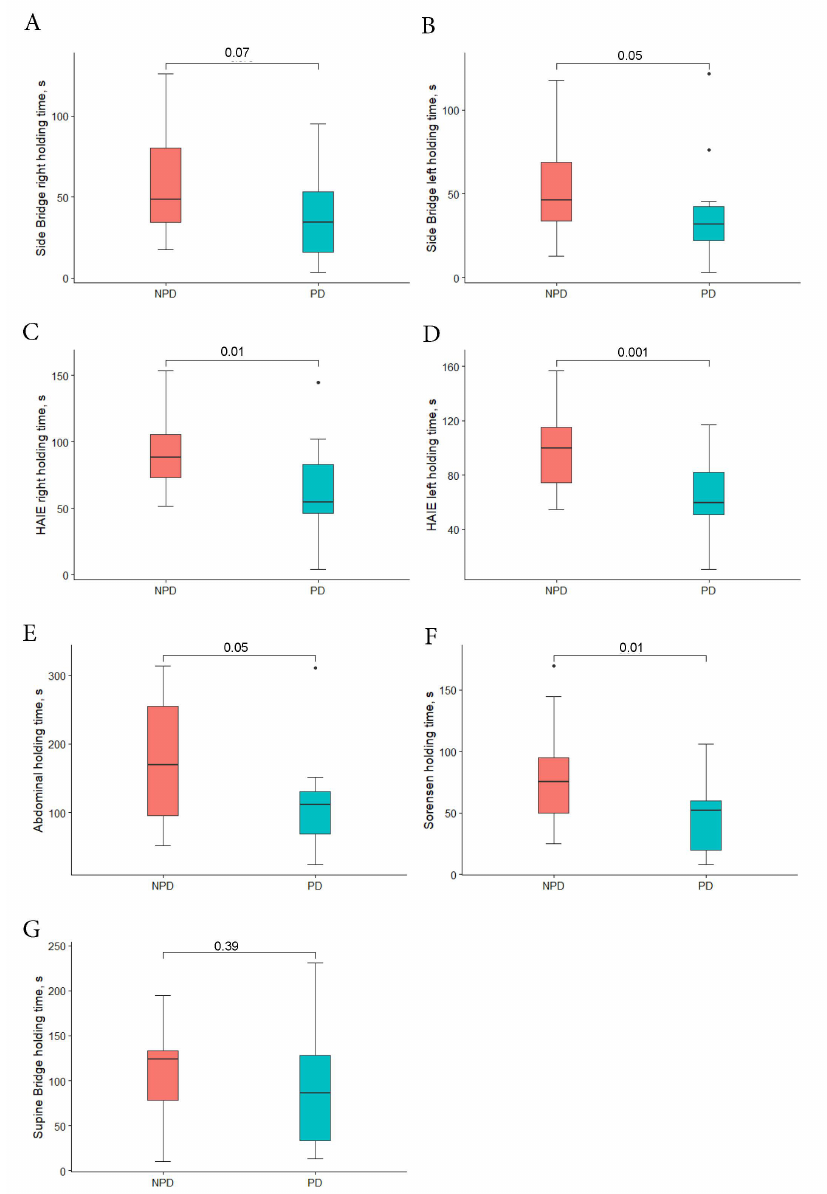
Figure 2. Endurance test. ( A ) Side bridge right side, ( B ) side bridge left side, ( C ) HAIE right side, ( D ) HAIE left side, ( E ) abdominal, ( F ) Sorensen, ( G ) supine bridge holding times for individual NPD ( n = 26) and PD ( n = 14). In the box plot, red boxes represented NPD and blue boxes represent PD; horizontal bold lines show the medians, and the box limits indicate the 25th and 75th percentiles. Whiskers extend one and a half times the length of the box (interquartile range), and dots represent the outliers. p obtained from the Mann–Whitney U test or t-Student test for independent samples. NPD, non-pain developers; PD, pain developers; s, seconds; HAIE, Hip Abductor Isometric Endurance